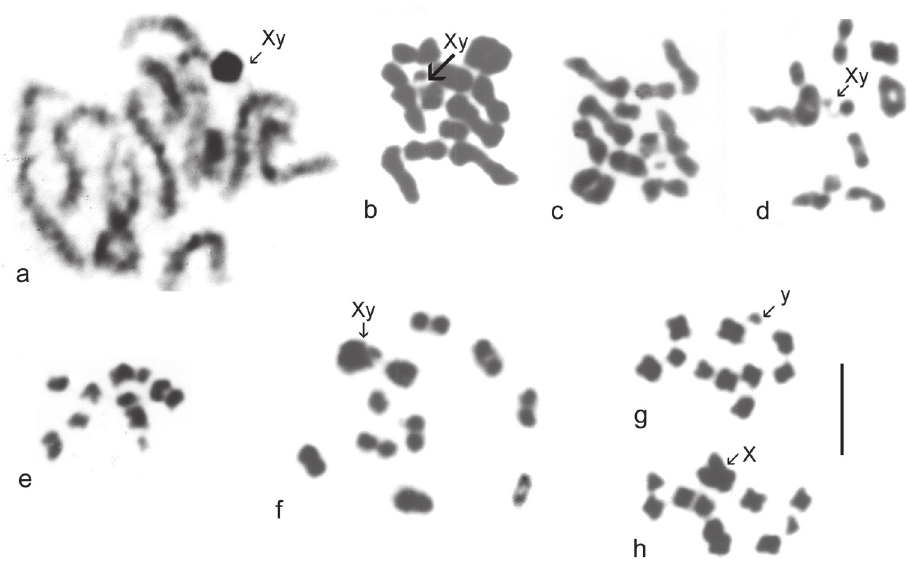
Figure 5. Meiosis of Leiodidae (surface forms). a–e Leiodes calcarata f–h Catops coracinus a prophase I, zygotene b–d metaphase I e , metaphase II, ♂ -determining, with y chromosome f metaphase I g , h meta- phase II g ♂ -determining, with y chromosome h ♀ -determining, with X chromosome. Scale bar = 5